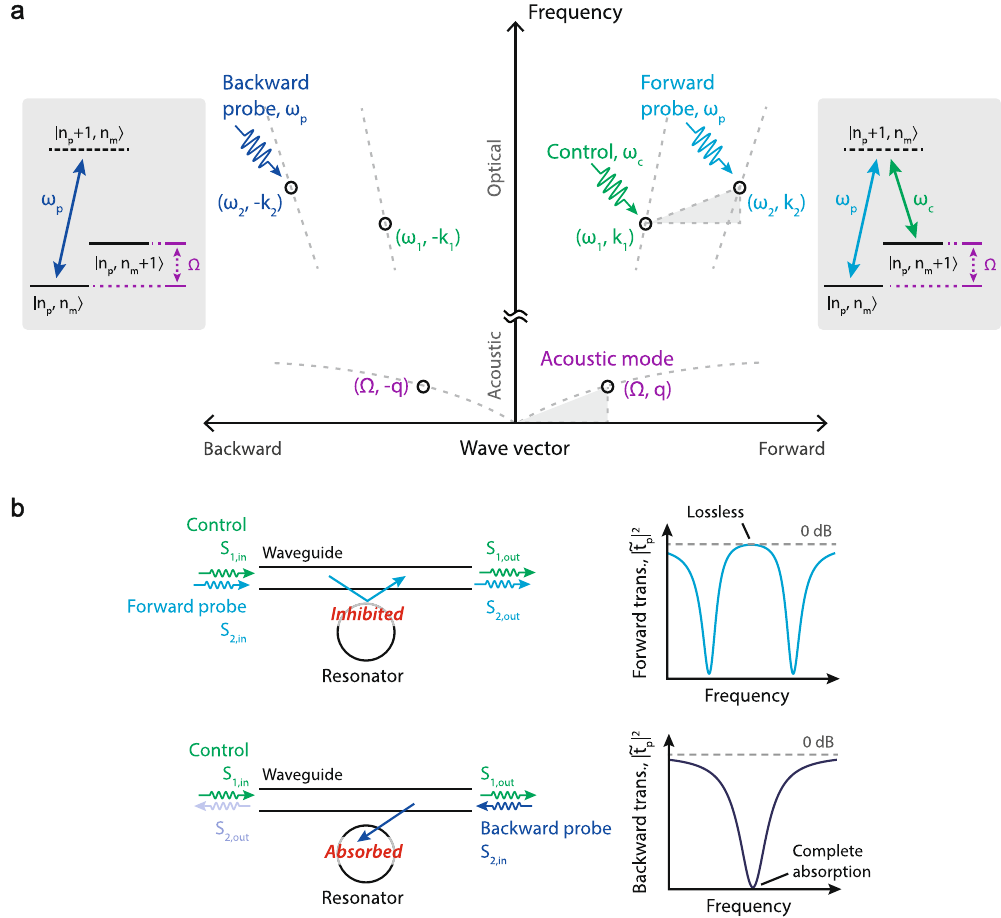
Figure 1. Achieving optical isolation through non-reciprocal Brillouin scattering induced transparency in a whispering-gallery resonator: ( a ) The interference of excitation pathways in the BSIT system are described through an energy-level picture (grey boxes), using probe photon number n p and phonon number n m . Absorption of a probe photon into the ( ω 2 , k 2 ) optical resonance is modeled as an effective transition | 〉 → | + 〉 n n n n , 1, p m p m . In presence of the control field, the probe photon could scatter to the lower resonance ( ω 1 , k 1 ) while adding a mechanical excitation in (Ω, q), which is an effective transition to state | + 〉 n n , 1 p m . However, the coherent anti-Stokes scattering of the control field from this mechanical excitation would generate an interfering excitation pathway for the original state | + 〉 n n 1, . This process is analogous to EIT and results p m in a window of transparency for the forward optical probe, inhibiting the original | 〉 → | + 〉 n n n n , 1, p m p m absorption transition. The necessary momentum matching requirement, not visible in the energy diagram, is represented using the dispersion relation (middle) to elucidate the breaking of time-reversal symmetry for the probe signal. ( b ) We implement this mechanism using a waveguide and a whispering gallery resonator, in which probe signals tuned to either of the ( ω 2 , ± k 2 ) optical resonances are typically absorbed by the resonator under the critical coupling condition. The presence of a forward control field, however, creates the BSIT interference 26 , only for forward probe signals and inhibits absorption. Under strong acousto-optical coupling, the waveguide- resonator system is rendered lossless at the original 2 transmission = ˜ t 1 even when the waveguide and resonator are critically coupled. Forward propagating probe p light in the waveguide, co-propagating with the control laser, can thus transmit perfectly with no absorption at resonance in the ideal case. At the same time, we have no Brillouin coupling ( β = 0 ) for counter-propagating control and probe optical fields due to the momentum mismatch as indicated previously. This implies that, for a counter-propagating probe, the system remains in the critical coupling region resulting in complete absorption. Since forward probe signals transmit with zero absorption, and backward probe signals are completely absorbed (Fig. 1b), this system is an ideal linear isolator at the transparency resonance. A more practically accessible case is κ ≥ G , also known as the strong coupling regime 32 , where the induced 2 transparency grows to the width of the optical mode. Strong coupling can be reached for high coherence phonon modes (small Γ B ) with large acousto-optic coupling β and large control driving field s . The evolution of the 1,in optical transparency and isolation contrast with increasing coupling G is illustrated in Fig. 2. In the weak coupling regime ( κ  G ) the isolation contrast is defined roughly by the linewidth of the phonon mode. As G increases 2